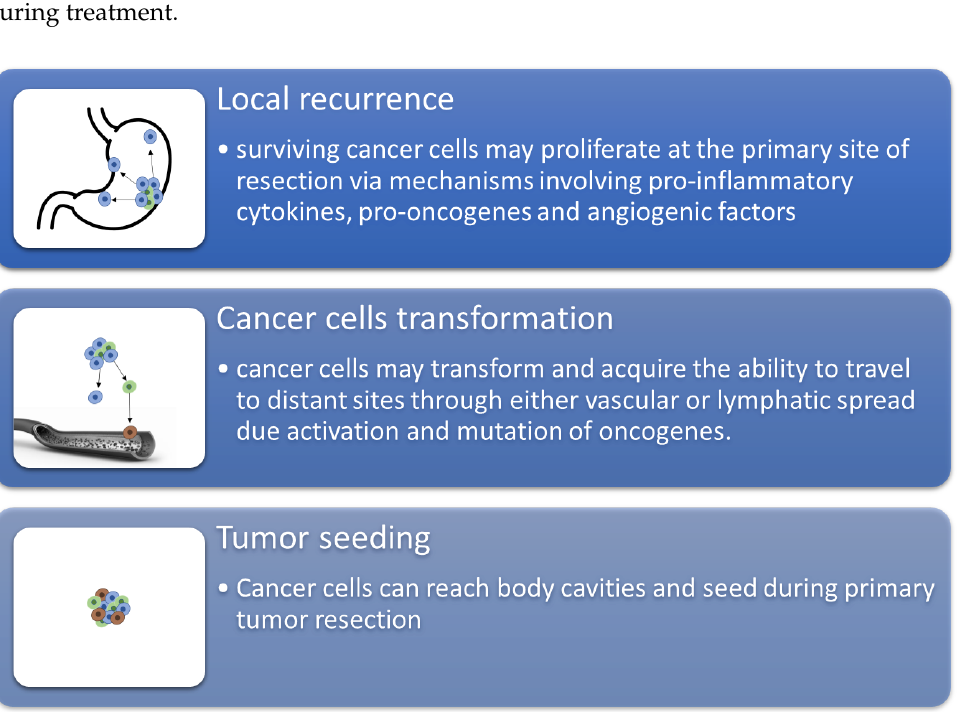
Figure 6. The schematization of recurrence and metastasis through three main mechanisms.